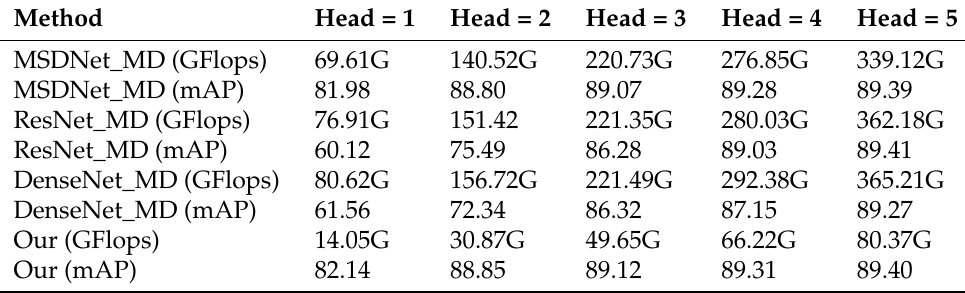
Table 7. Performance of anytime prediction models on the RSOD